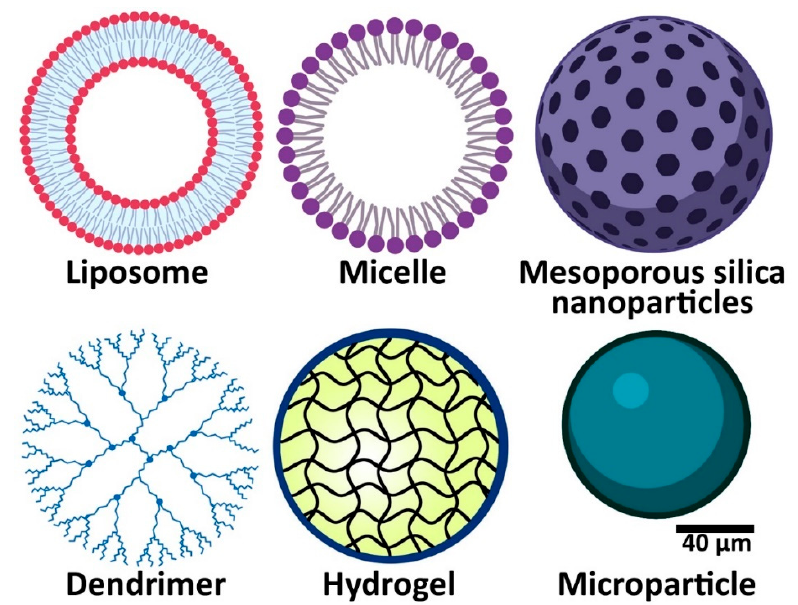
Figure 1. Drug delivery platforms used in the treatment of oral diseases.